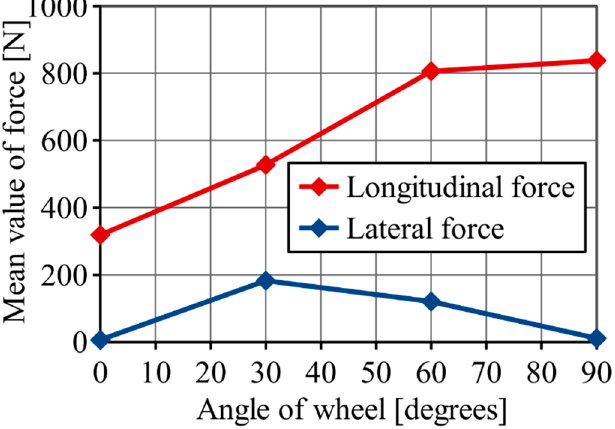
Figure 7. Values of the mean longitudinal and lateral forces based on the angle of attack [21].